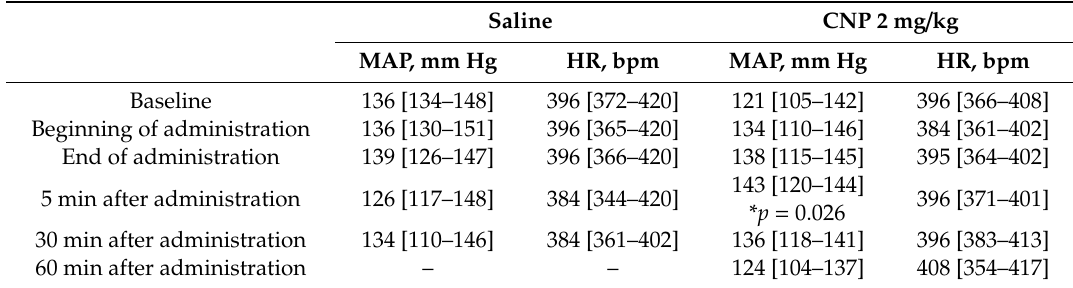
Table 2. Indicators of systemic hemodynamics following administration of a CNP suspension. Saline CNP 2 mg / kg MAP, mm Hg HR, bpm MAP, mm